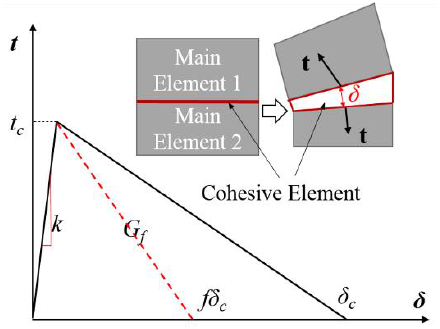
δ ) model for the cohesive